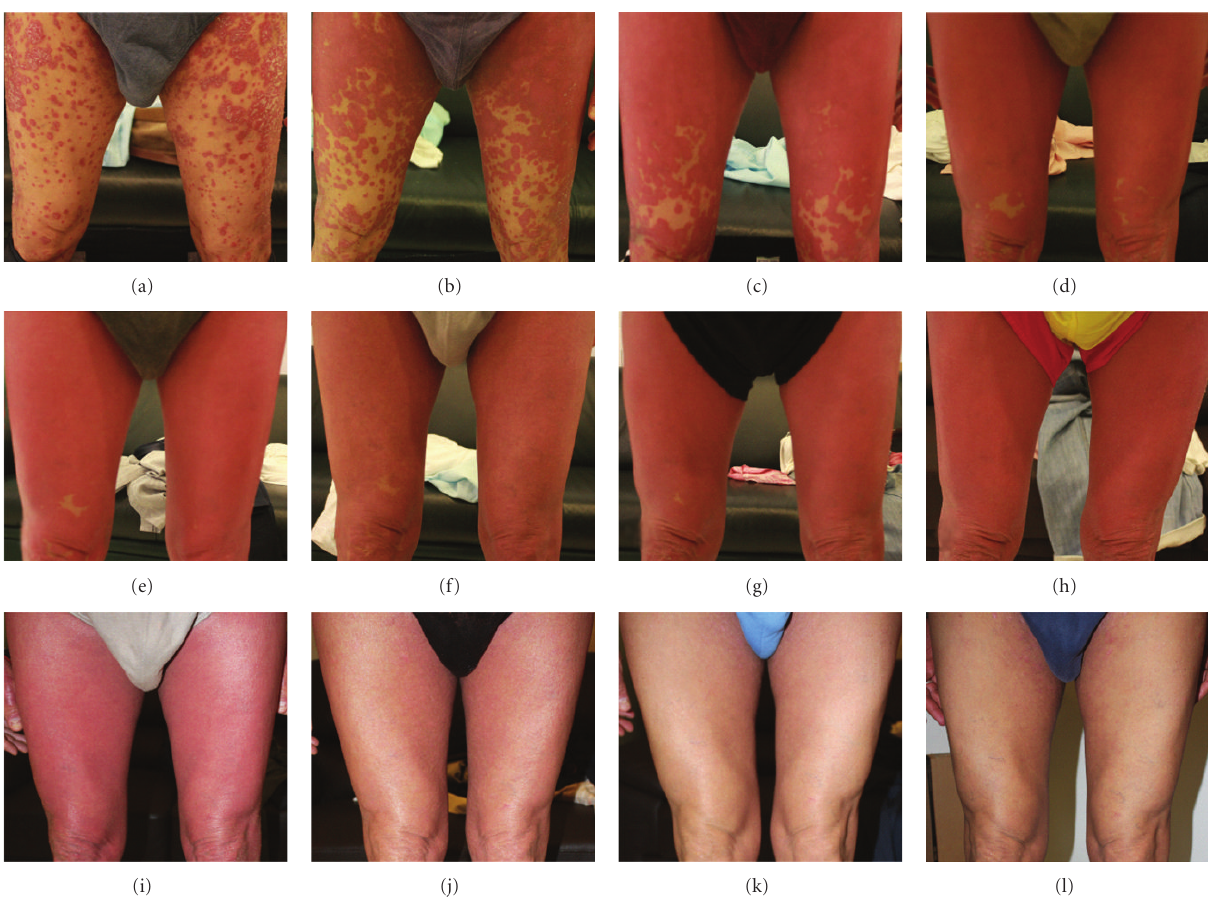
Figure 6: Evolution of psoriasis lesion in patients with prior immunosuppressants therapy. (a) Month 0. Photograph before initiating herose. (b) Month 1. (c) Month 2. (d) Month 3. (e) Month 4. (f) Month 5. (g) Month 6. (h) Month 9. (i) Month 12. (j) Month 18. (k) Month 26. (l) Month 32. Patient experienced 200% worsening of PASI score from month 1 (b) to month 6 (g) relative to baseline value (a), which was the immunosuppressants withdrawal syndrome, the severity of psoriasis flared up to a high point, but henceforth progressively tapered down, flakes exfoliated from psoriatic lesion reduced in size and finer flakes shed o ff , psoriatic plaques became thinner as shown at month 18 (j), improvement of PASI75 was achieved at month 26 (k), psoriatic plaques eradicated, and the subsided lesion area faded to a greyish colour (k,